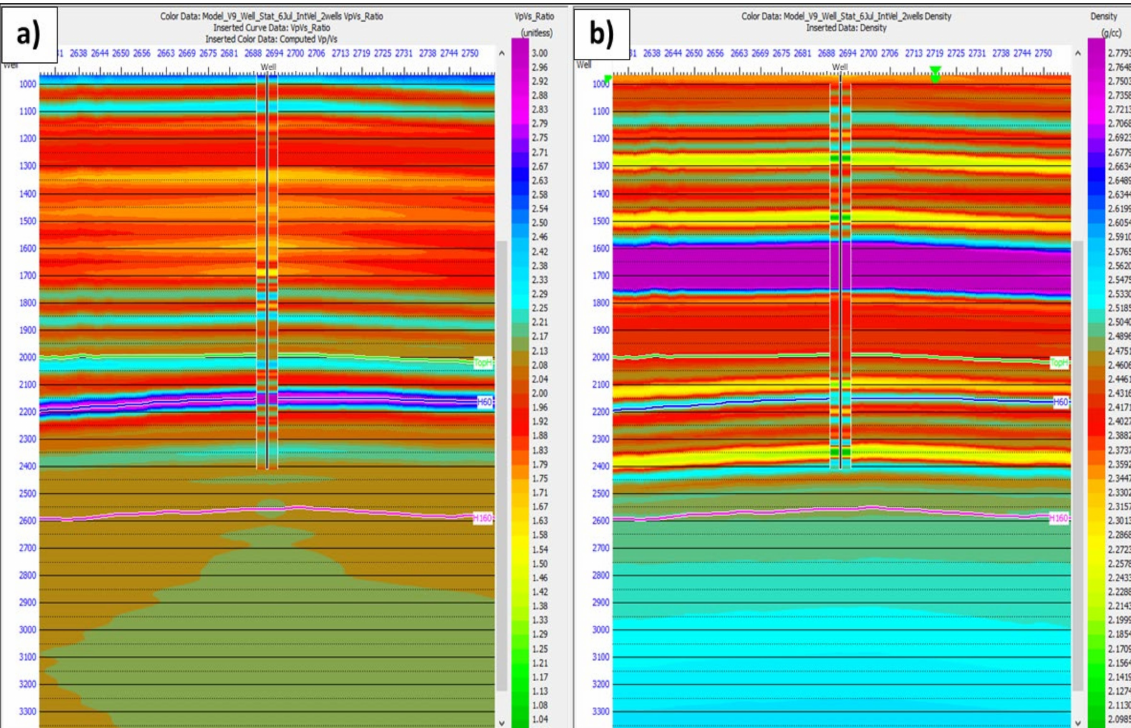
Figure 14. Initial seismic model of ( a ) Vp/Vs ratio and ( b )